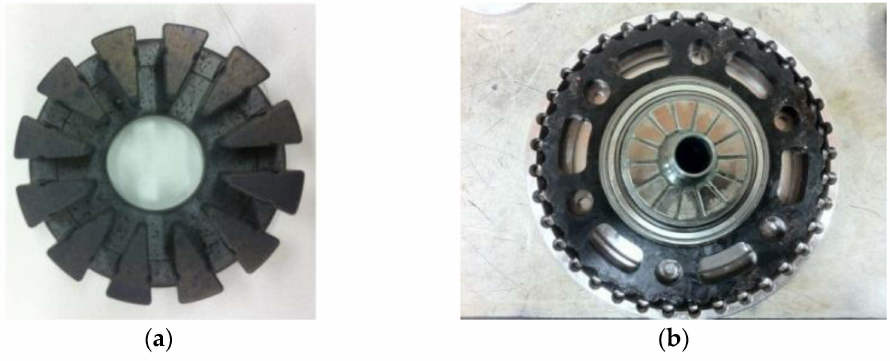
Figure 10. ( a ) Stator; and ( b ) the rotor embedded in the cycloidal